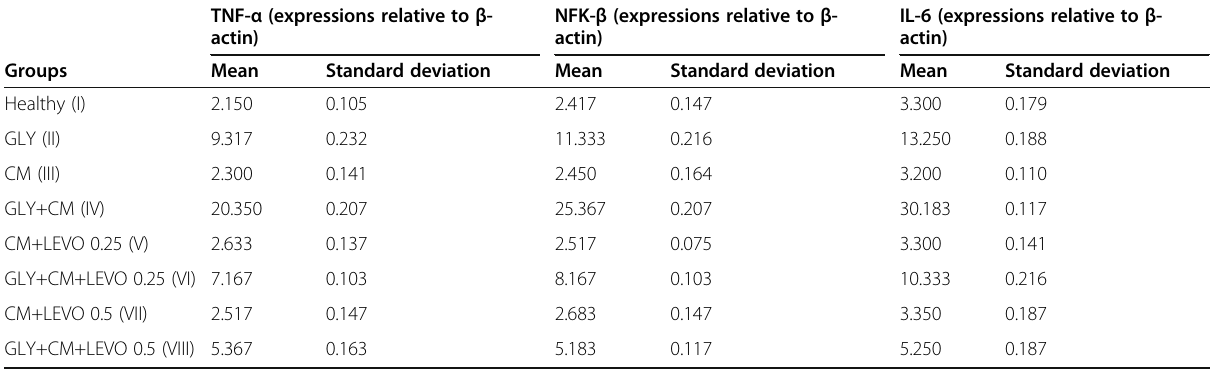
Table 3 The mean tumour necrosis factor α (TNF- α ), nuclear factor kappa β (NFK- β ), and interleukin 6 (IL-6) expressions according to experimental groups